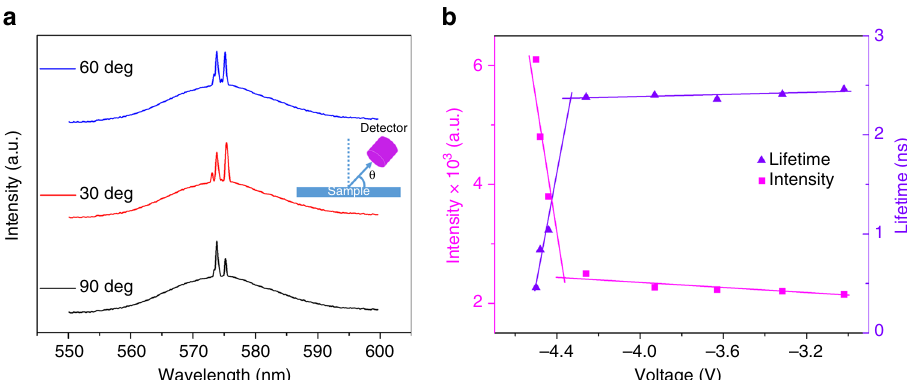
Fig. 4 Divergence of emitted spectrum and carrier lifetime. a The angular dependence of EL spectra at a bias voltage of 4.48 V, above lasing threshold of reverse bias. The inset denotes the schematic measurement setup, where θ is the angle between sample plane and the detector. b Dependence of carrier lifetime and integrated EL intensity on pumping voltage. The lifetime of the carriers become faster at the lasing threshold, which is due to avalanche appearance of massless electrons originated from the vicinity of the Dirac point of the graphene layer. The obtained lifetime data contain ± 0.2 ns errors induced by